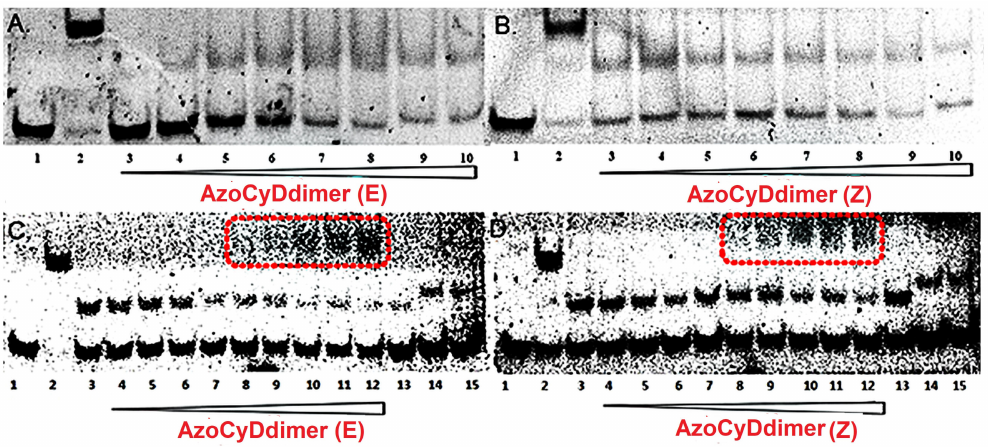
Figure 5. EMSA analysis of DNA binding of Ad30 peptide in the presence and absence of azoCyDdimer. ( A ) Lanes 1–10: 50 nM AP1 ( (cid:48) 5-cggATGA c TCATtttttttc-3 (cid:48) ); lane 2: 300 nM SS60; lanes 3–10: 200 nM Ad30 and 0, 0.5, 1, 2, 5, 20, 50, 100 equivalents azoCyDdimer (E). ( B ) Lanes 1–10: 50 nM AP1 ( (cid:48) 5-cggATGA c TCATtttttttc-3 (cid:48) ); lane 2: 300 nM SS60; lanes 3–10: 200 nM Ad30 and 0, 0.5, 1, 2, 5, 20, 50, 100 equivalents azoCyDdimer (Z). ( C ) Ad30 and azoCyDdimer (E): lane 1–13: 50 nM CRE ( (cid:48) 5-cggATGA cg TCATtttttttc-3 (cid:48) ); lane 2: 100 nM SS60; lanes 3–15: 200 nM Ad30; lanes 3–10: azoCyDdimer (E): 0, 0.5, 1, 2, 10, 50, 100, 500 eq.; lane 11–12: excess of azoCyDdimer (E) (0.15 mM); lane 13: Ad30 200 nM; lane 14: 50 nM ds mCRE ( (cid:48) 5-cggATGAcgttgtttttttc-3 (cid:48) ): 200 nM Ad30; lane 15: 50 nM mCRE ( (cid:48) 5-cggATGAcgttgtttttttc-3 (cid:48) ): 200 nM Ad30, 0,5 eq azoCyDdimer(E). ( D ) Ad30 and azoCyDdimer (Z) lane 1–13: 50 nM CRE ( (cid:48) 5-cggATGA cg TCATtttttttc-3 (cid:48) ); lane 2: 100 nM SS60; lane 3–10: 200 nM Ad30 and azoCyDdimer (Z): 0, 0.5, 1, 2, 10, 50, 100, 500 eq.; lane 11–12: Ad30: 200 nM and excess of azoCyDdimer (Z) (0.15 mM); lane 13: Ad30 200 nM; lane 14: 50 nM ds mCRE ( (cid:48) 5-cggATGAcgttgtttttttc-3 (cid:48) ); 200 nM Ad30; lane 15: 50 nM ds mCRE ( (cid:48) 5-cggATGAcgttgtttttttc-3 (cid:48) ): 200 nM Ad30, 0,5 eq. azoCyDdimer (Z). DNA was detected by fluorescent staining with